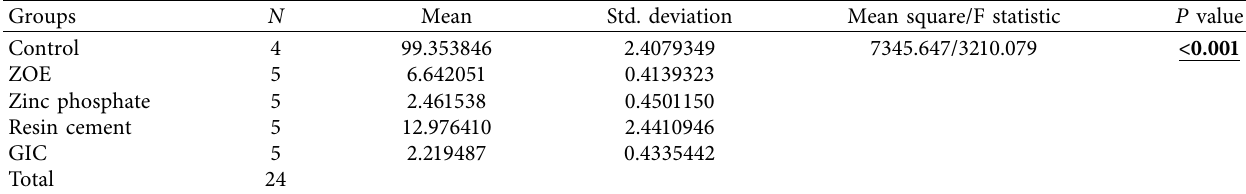
Table 2: Comparison of the viability of all the 4 experimental groups and the control group.